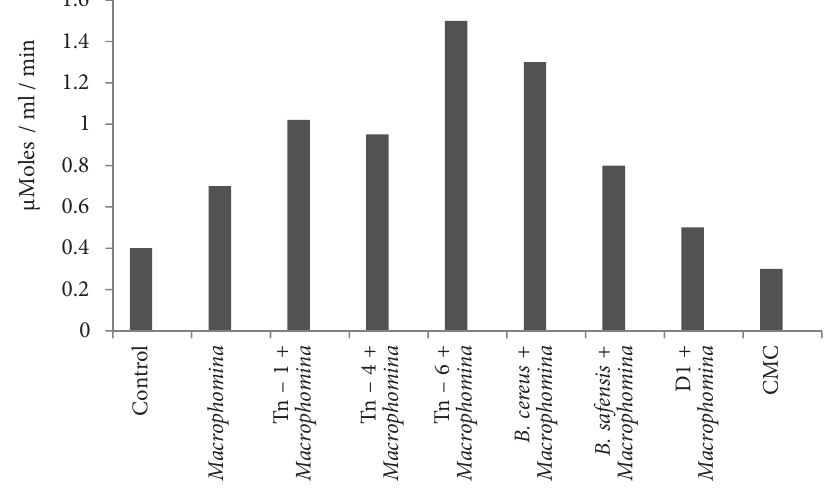
Figure 7. Graphical representation of phenylalanine ammonia lyase (PAL) activity in rhizobacteria treated plant